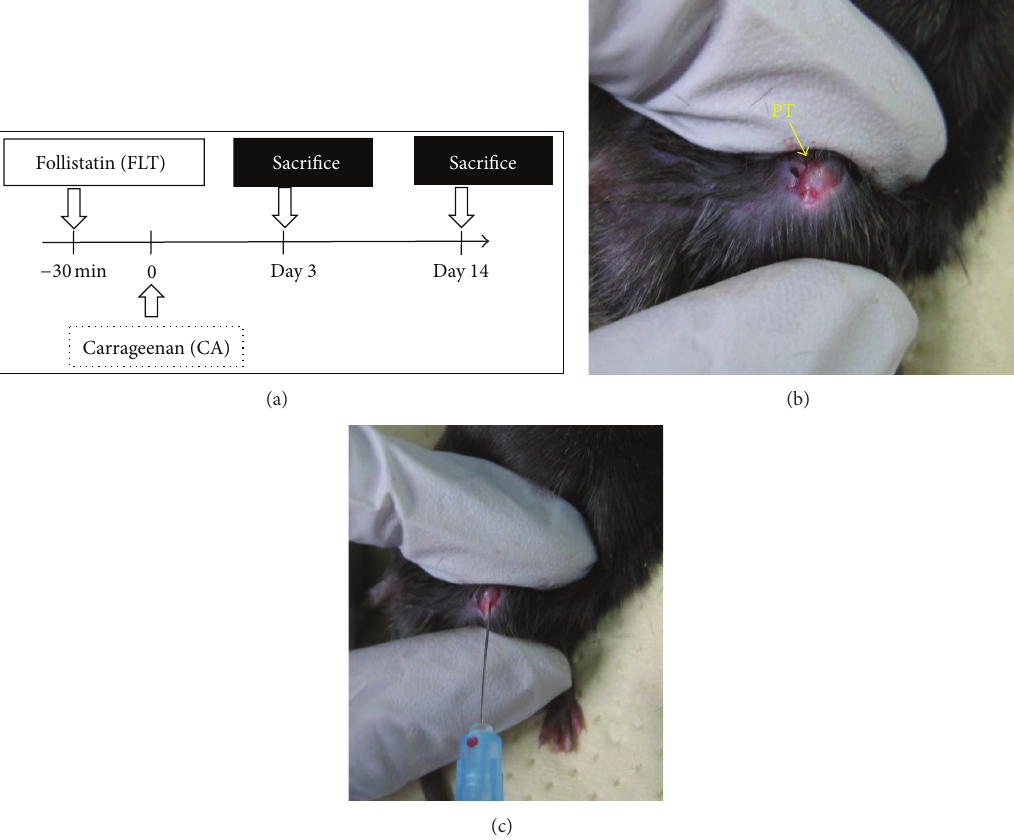
Figure 1: Carrageenan-induced arthritis model. (a) Experimental design of carrageenan-induced arthritis model. Twenty-eight male mice (12-week-old) were registered in this study. Mice were randomly divided into two groups: carrageenan group (CA) and carrageenan + follistatin (CA + FLT) group ( 𝑛 = 14 /group). Histological analyses were performed at days 3 and 14. (b, c) Procedure of intra-articular injection of carrageenan. PT: patellar